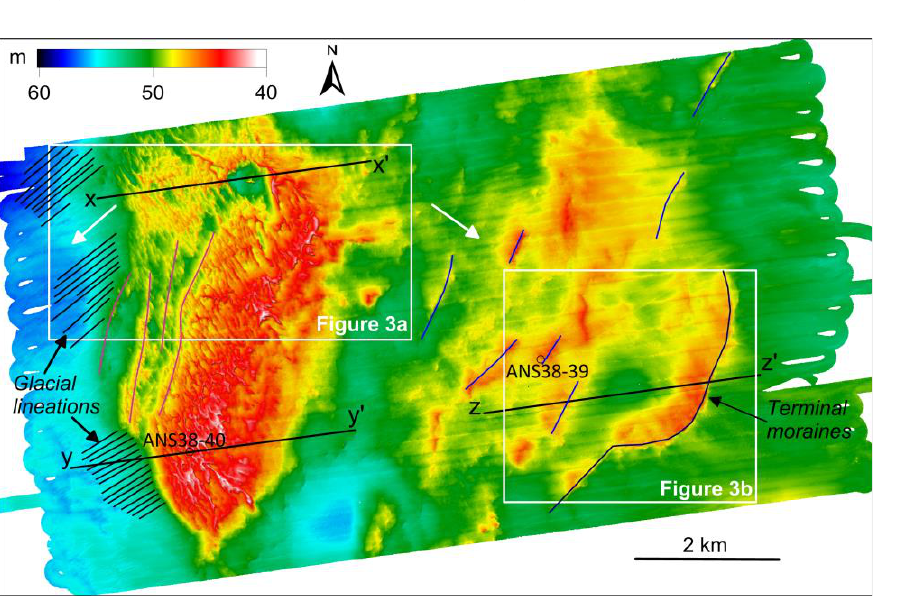
Figure 4. Sub-bottom cross-sections through the glacial landforms mapped within Area 1; see Figure 2 for locations. Arrows point to: ( a ) Ring structure; ( b ) Glacial linear features; ( c ) Terminal moraine.